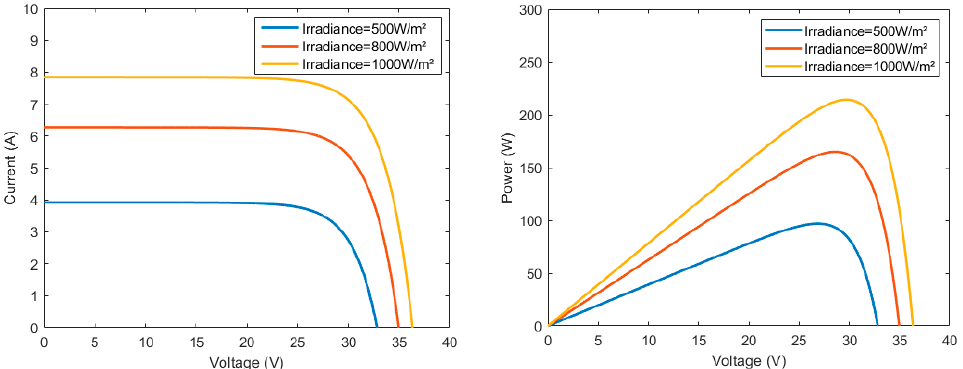
Figure 1. Characteristic curves of constant temperature and change of irradiance.